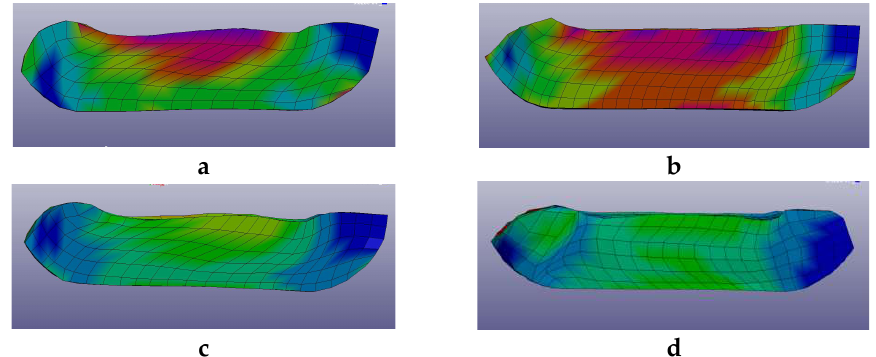
Figure 4. Strain intensity distribution after 2 ECAP passes done: a —along mode A, b —along mode B C , after 3 ECAP passes done: c —along mode A, d —along mode B C . The relative scale is between minimum strain = blue, intermediate strain = green and maximum strain = red without any physical meaning. Molecules 2018 , 23 , x; doi: FOR PEER REVIEW